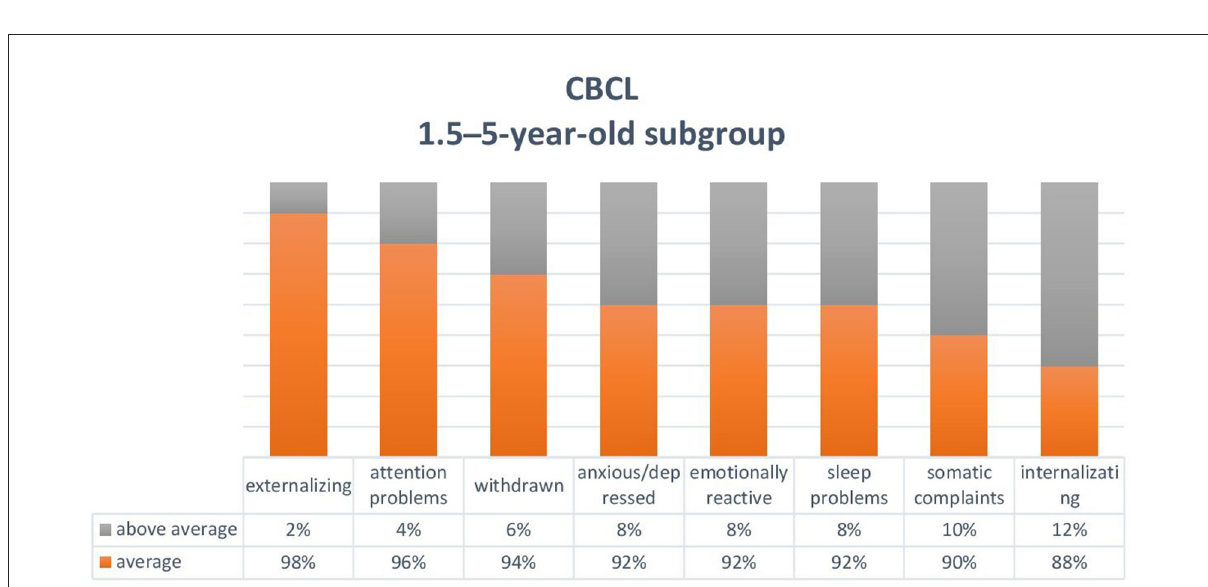
FIGURE2 Child Behavior Checklist (CBCL) for the 1.5-5-year-old